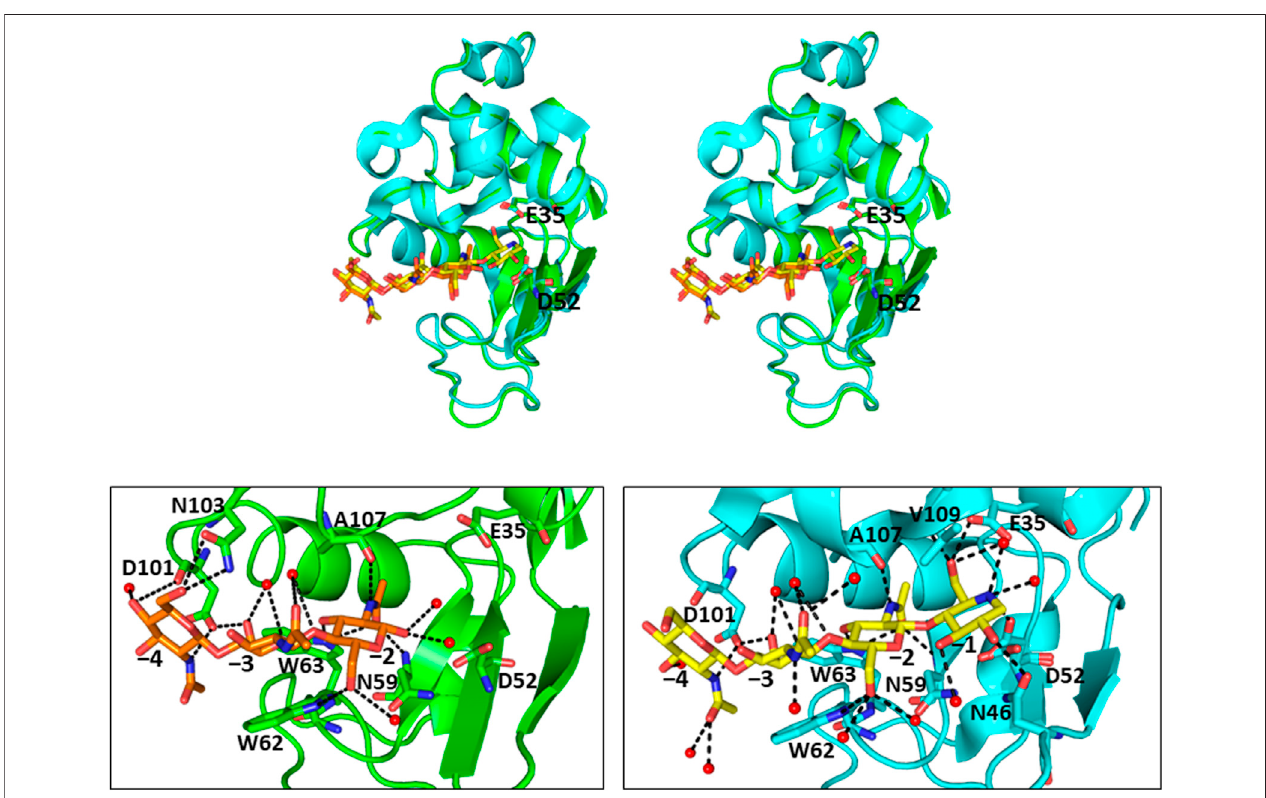
FIGURE 3 | Crystal structures of(GlcNAc) 3 -liganded and GN 3 M-liganded HEWL (A) Stereo view of superimposed structures of (GlcNAc) 3 -liganded HEWL (green; PDB code 1lzb) and GN 3 M-liganded HEWL (cyan; PDB code 4hp0) complexes. The catalytic residues Glu35 and Asp52 ofHEWL are indicated assticks(GlcNAc) 3 and GN 3 M are shown as orange and yellow sticks, respectively. (B) The binding modes of (GlcNAc) 3 and GN 3 M to HEWL. Amino acid residues involved in the binding of ligands (GlcNAc) 3 and GN 3 M are also indicated as sticks. The numbers, − 4 to − 1, indicate the subsite positions. Dashed lines indicate the possible hydrogen bonds. Red spheres represent oxygen atoms of water molecules.